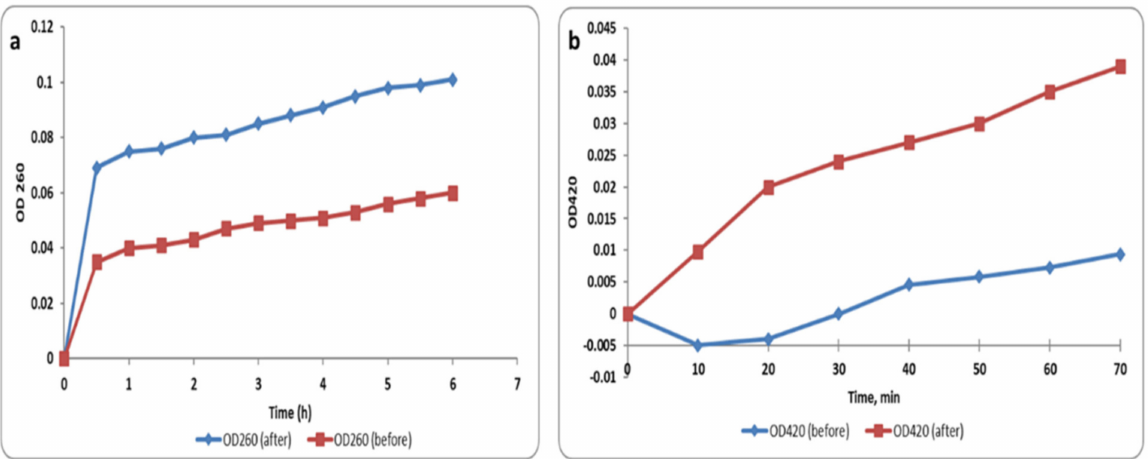
Figure 9. Line chart showing ( a ) the cell membrane integrity and ( b ) the membrane permeability of a representative S. aureus isolate before and after treatment with the green-synthesized AgNPs (at concentrations equal to 0.5 MIC